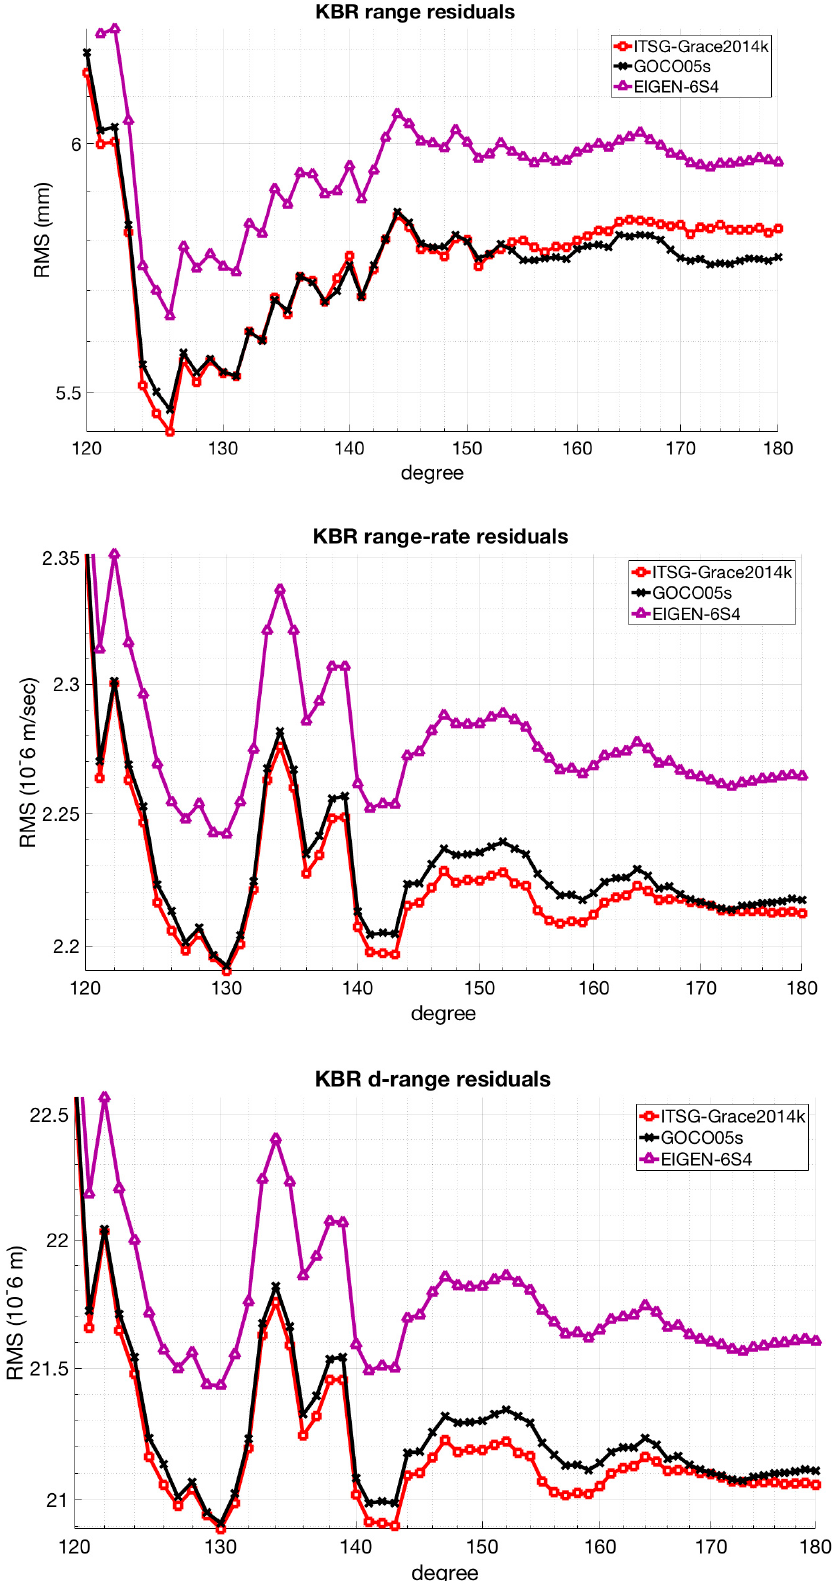
Figure 2. RMS variances of KBR data residuals to the GRACE estimated orbits based on time-variable gravity field models. The term d-range refers to the approach of eliminating the KBR range bias based on sequential range differences.